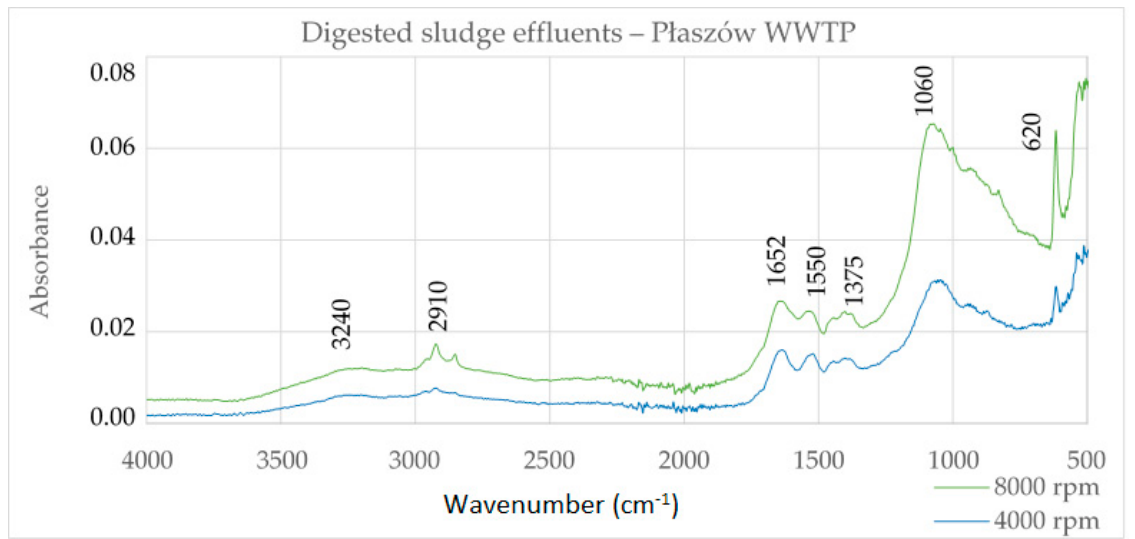
Figure 1. Infrared (FTIR) spectra of digested sludge effluents of the P ł aszów WWTP.